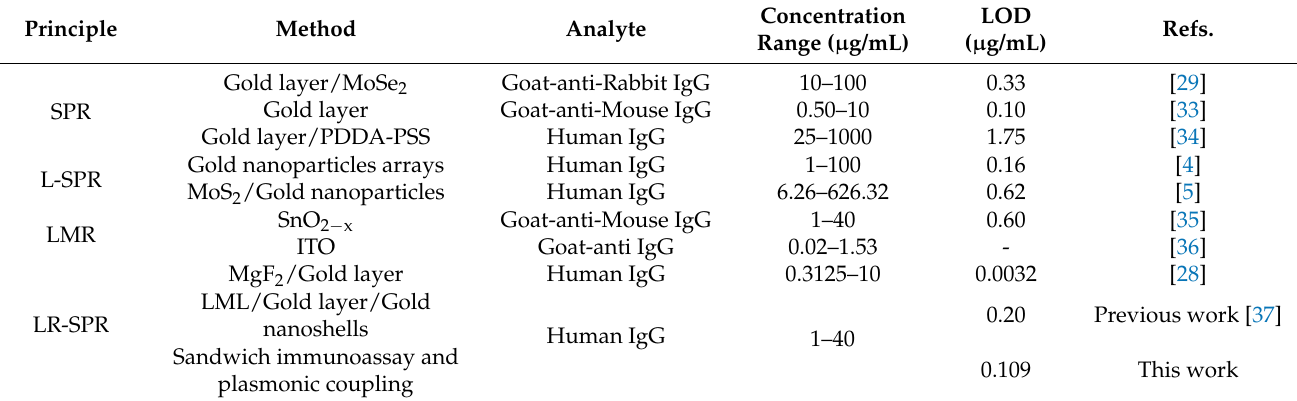
Table 2. Comparison of the research results in this paper with those reported in recent years.